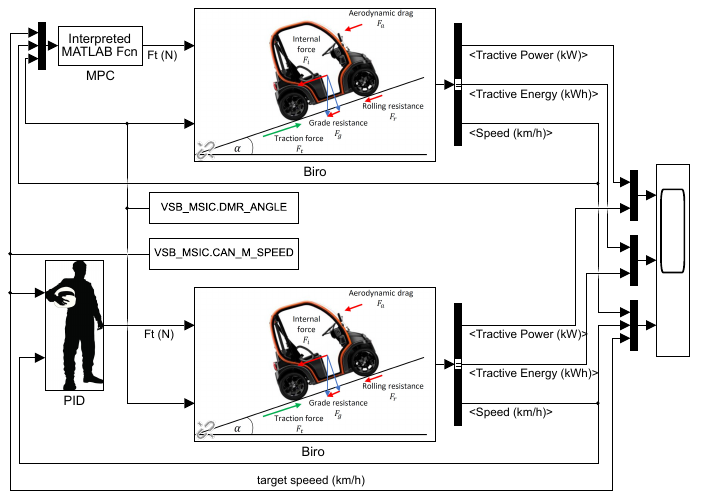
Figure 13. Comparison of MPC and PID control